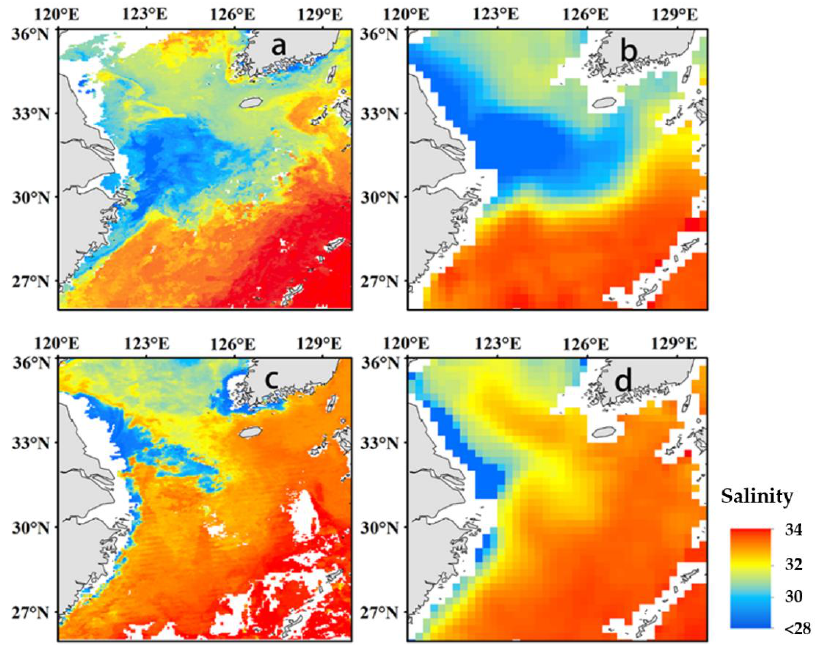
Figure 7. Comparisons between the inversion SSS and monthly SMAP \ SSS product (( a , c ) are the inversion SSS for August and March 2020; ( b , d ) are SMAP \ SSS product in August and March 2020).